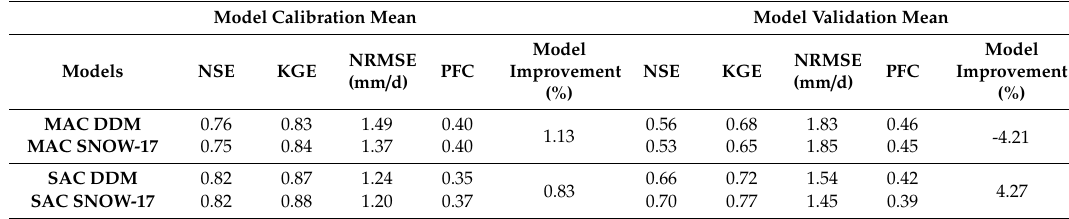
Table 2. Annual model performance statistics for LGRB.